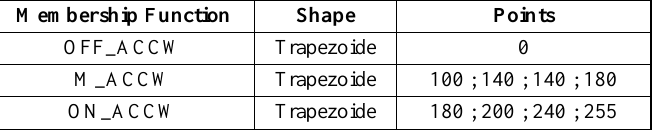
Table 7: Functions member of the Polar motion motor.